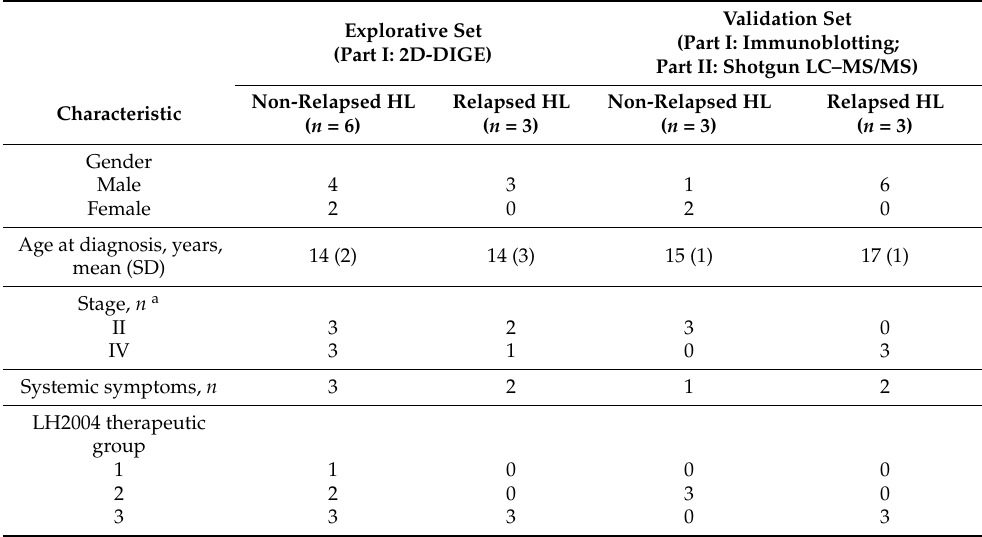
Table 1. Clinicopathological characteristics of patients with pediatric Hodgkin lymphoma (all nodular sclerosis type) who had either a favorable (non-relapsed) or unfavorable (relapsed) response to treatment in the LH2004 trial and from whom EVs were